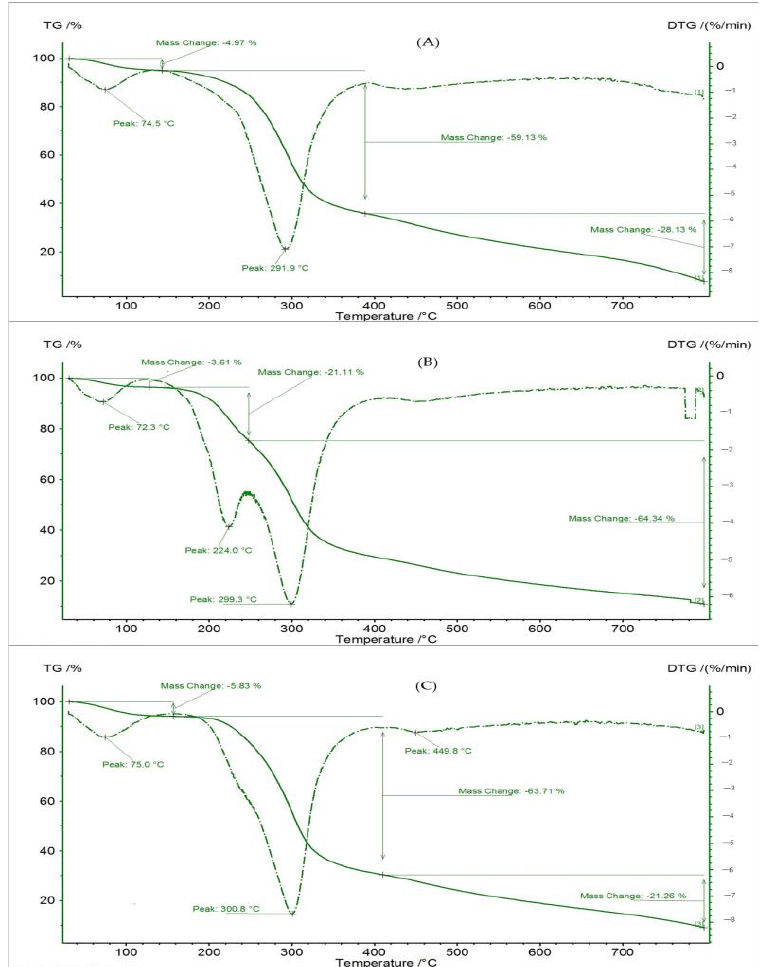
Figure 8. TG (%, continuous line) and DTG (%/min, discontinuous line) curves of the microcapsules. ( A ) GAM, gum arabic microcapsule (CSP extract coated with GA), ( B ) MDM, maltodextrin microcap- sule (CSP extract coated with MD), ( C ) GMM, gum arabic + maltodextrin microcapsule (CSP extract coated with the mixture of